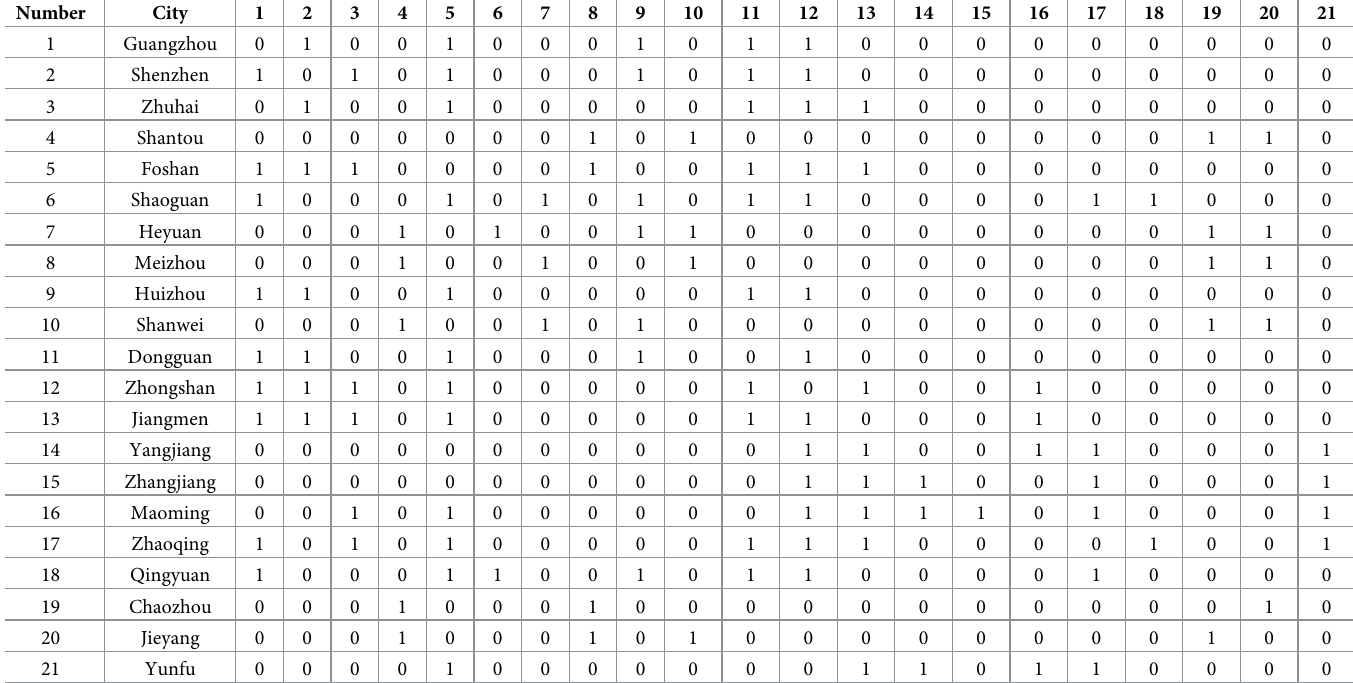
Table 4. Modal network of 21 cities in